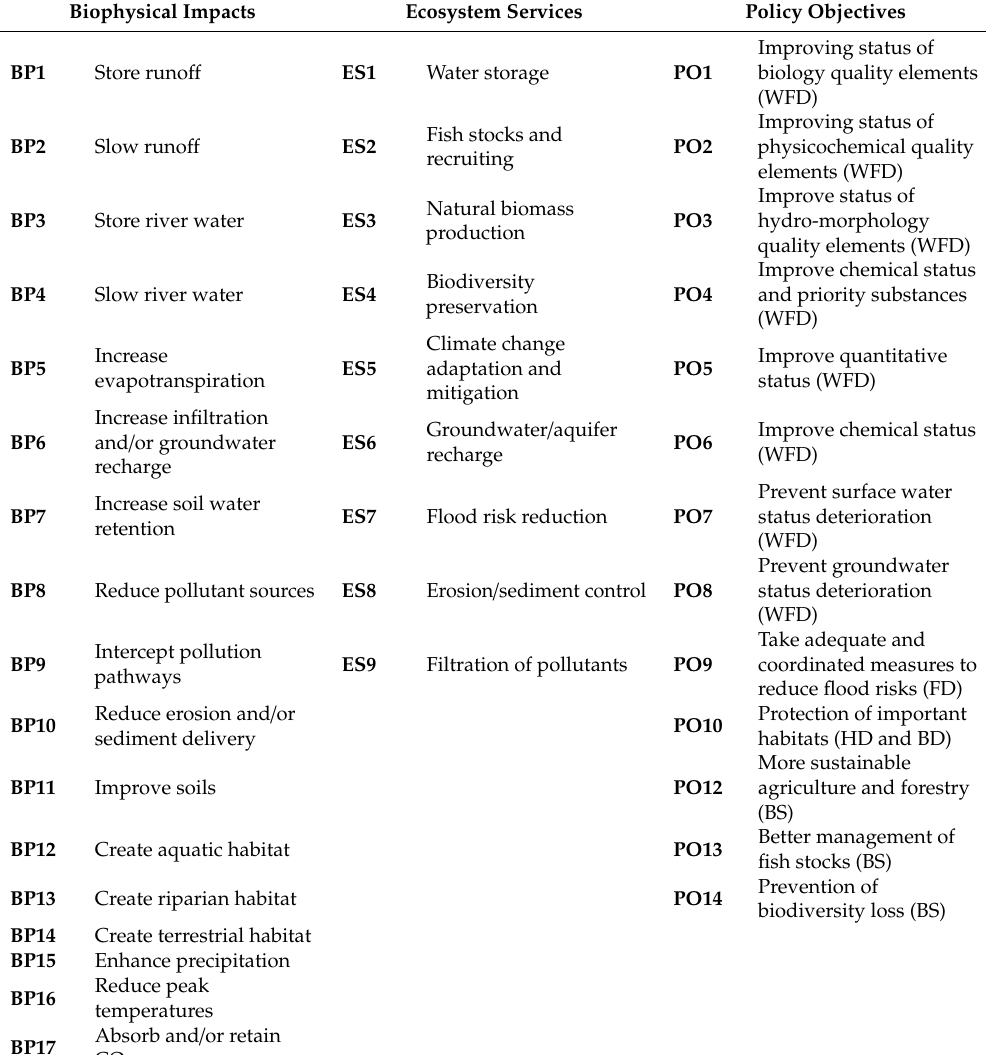
Table 2. Catalogue of the studied biophysical impacts, ecosystem services, and policy objectives linked to natural water retention measures, based on the NWRM project [29]. Short-names in bold are the ones displayed in the final